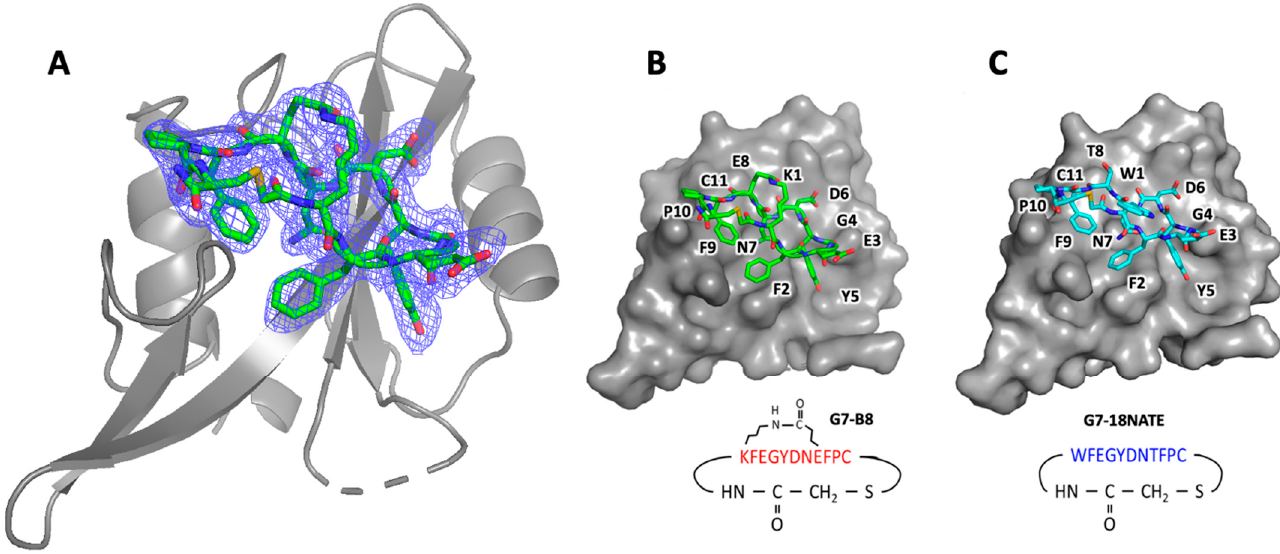
Figure 3. Structure of the G7-B8 peptide bound to the Grb7-SH2 domain compared to that of G7- 18NATE. ( A ) The structure of G7-B8 (green stick representation) is shown within the calculated electron density (blue mesh) bound to the Grb7 SH2 domain (grey cartoon representation) (PDB ID: 7MP3). ( B ) The same structure of G7-B8 (green stick representation) is shown bound to the Grb7 SH2 domain (grey surface representation). A schematic representation of the G7-B8 peptide showing the amino acid sequence in single-letter code (red font) is presented underneath. ( C ) The structure of G7-18NATE (blue stick representation) bound to the Grb7-SH2 domain (grey surface representation) is shown from the same orientation for comparison (PDB ID:3PQZ).